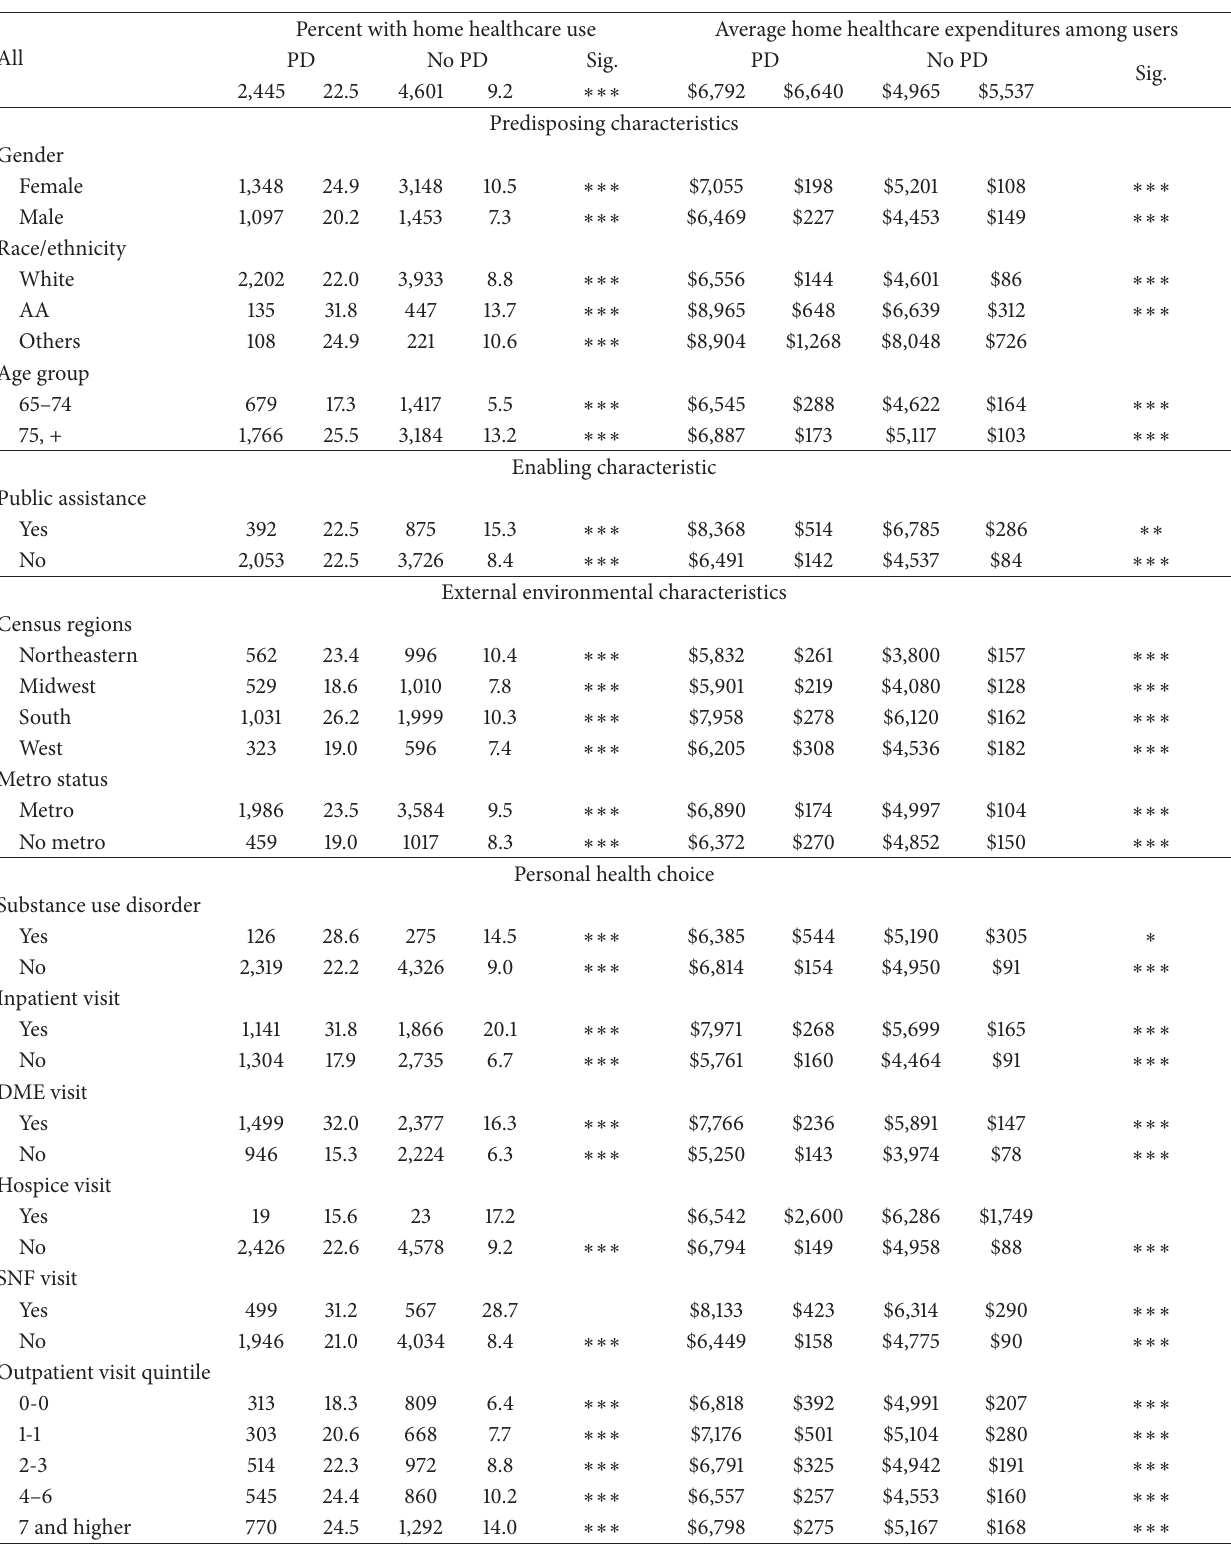
Table 2: Number and percent with home healthcare use and average home healthcare expenditures among users by Parkinson’s disease status among elderly Medicare beneficiaries. National Medicare 5% sample,